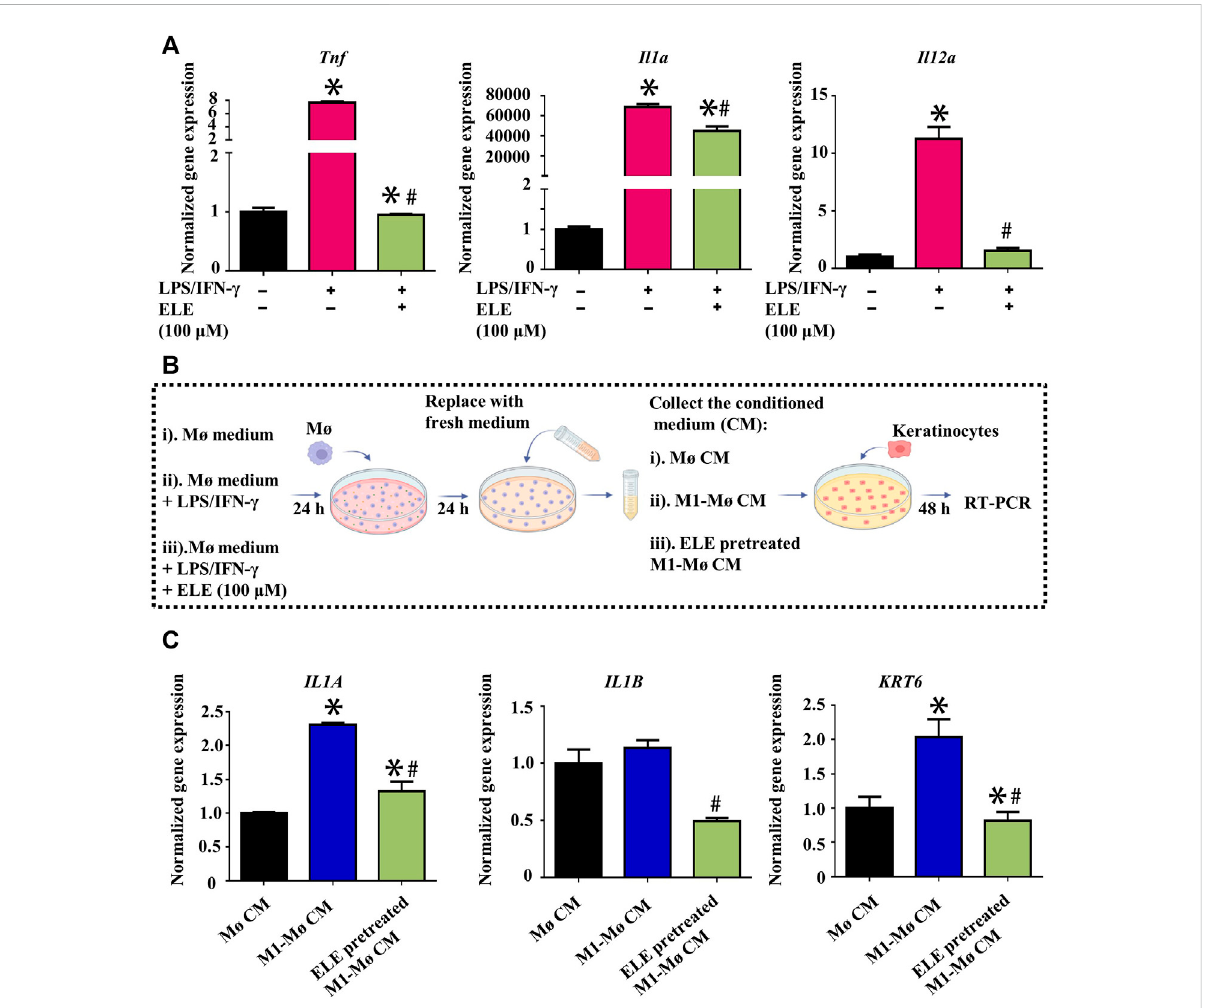
FIGURE 3 (A) Effects of ELE on the expression of Tnf, Il1a, and Il12a in M1-Mø. (B) Scheme illustration of the effects of Mø CM on keratinocytes. (C) Effects of M1-Mø and ELE-pretreated M1-Mø CM on the expression of IL1A, IL1B, and KRT6 in keratinocytes. * p < 0.05 versus control, # p < 0.05 versus LPS/ IFN- γ or M1-Mø CM. Error bars indicate SEM ( n =